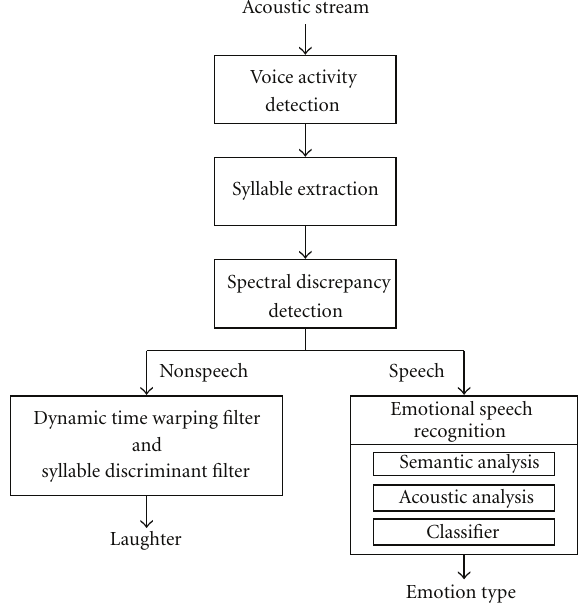
Figure 4: Workflow of the audio processing stage.